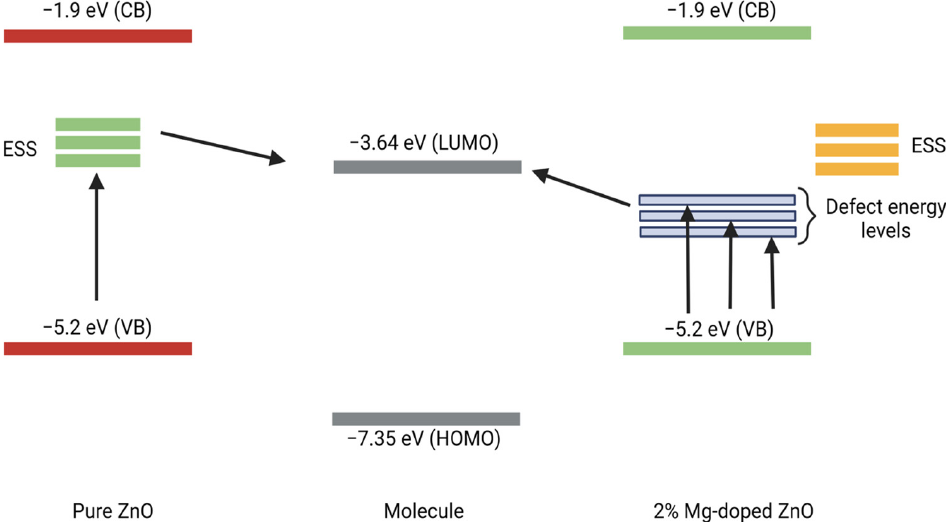
Figure A2. A schematic diagram showing potential differences in the charge-transfer mechanism of DTNB with pure ZnO and 2% Mg-doped ZnO.